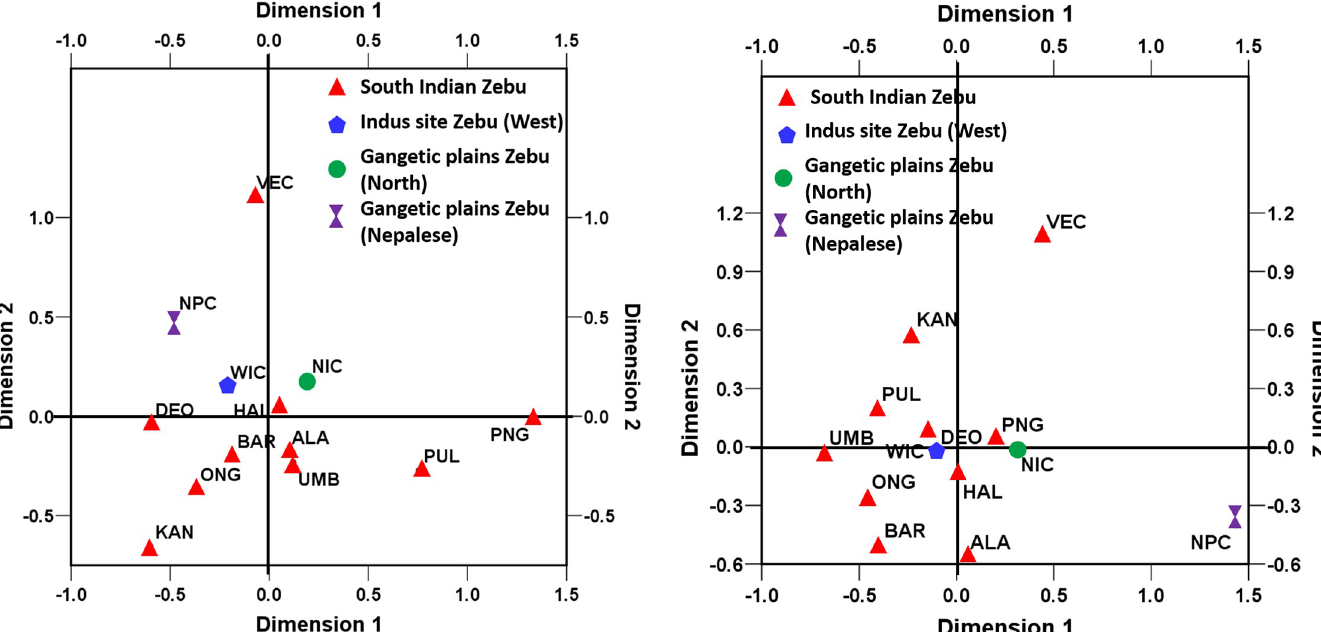
Fig 5. Multidimensional scaling display of pairwise F ST among (a) I1 mtDNA haplotypes and (b) I2 mtDNA haplotypes of zebu cattle from South India, North India, West India and Nepal (normalized raw stress for I1 and I2 haplotypes was 0.021 and 0.027 respectively).